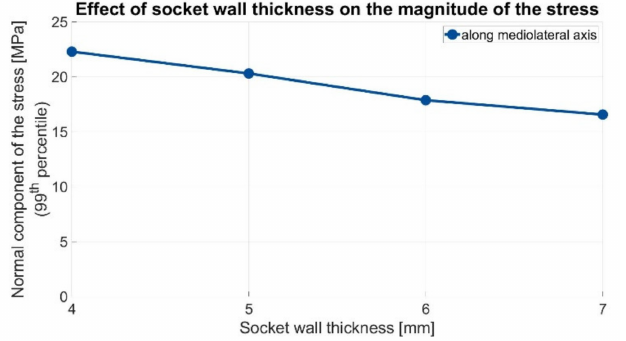
Figure 5. The 99th percentile of the normal component of the stress along the mediolateral axis when subjected to the load case of ISO 10328 describing toe-off is shown for sockets with differ- ent wall thicknesses. Peak values stayed below the maximum tensile strength of the FFF-printed tough PLA. Looking at the 99th percentile, the relative decay per thickness with respect to the socket with a 4 mm wall thickness was 8.9%, 20%, and 26% for sockets with 5-, 6-, and 7-mm wall thicknesses,